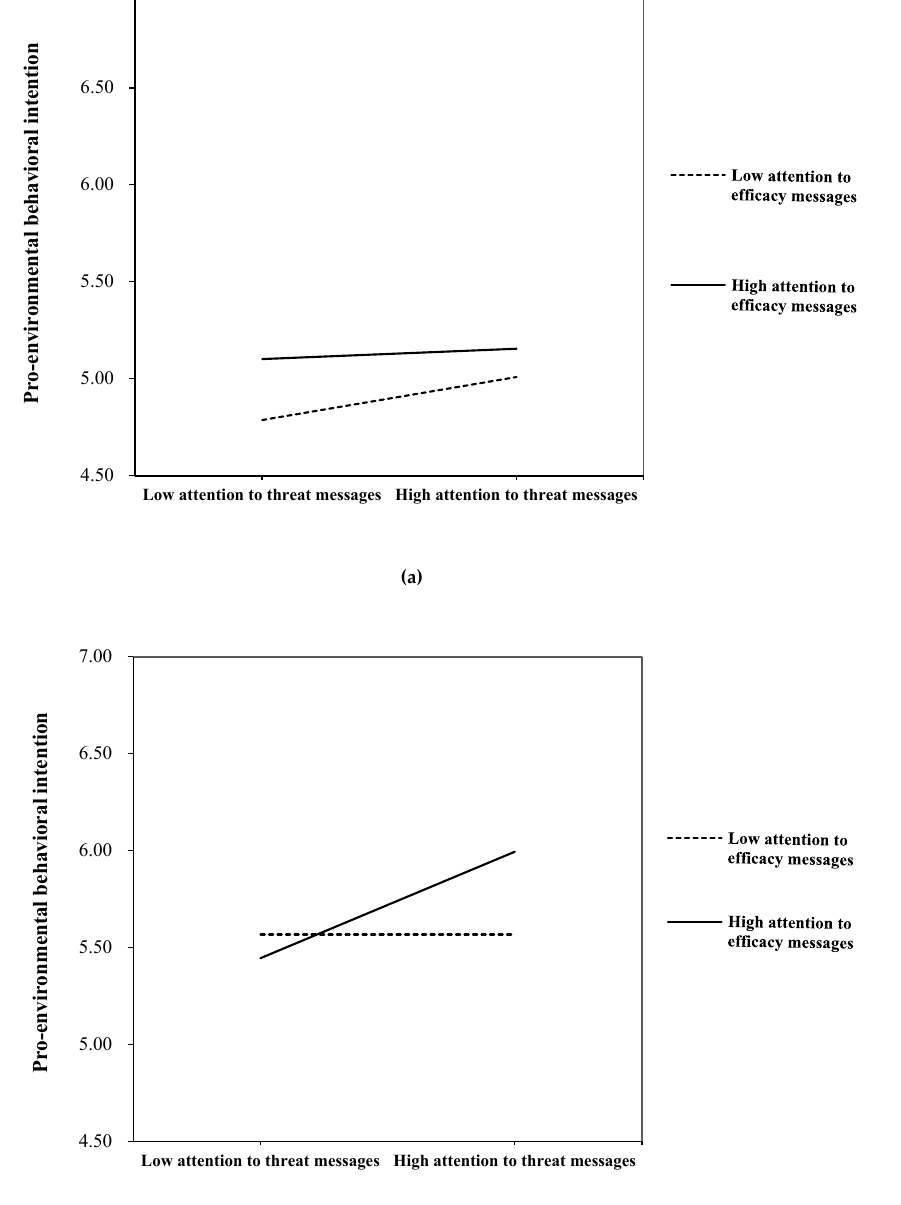
Figure 3. ( a ) Pro-environmental behavior intention by attention to efficacy messages and threat messages, when social norms are low. ( b ) Pro-environmental behavior intention by attention to efficacy messages and threat messages, when social norms are high.